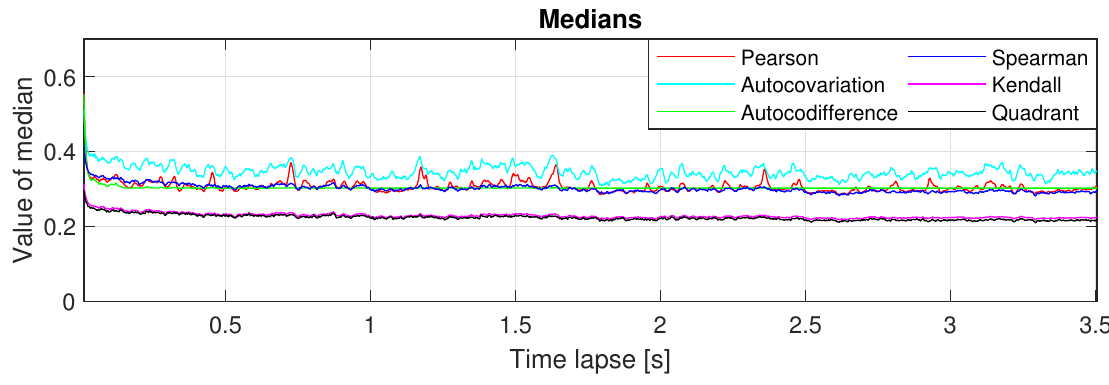
Figure 19. Medians for the frequency band at 4–12